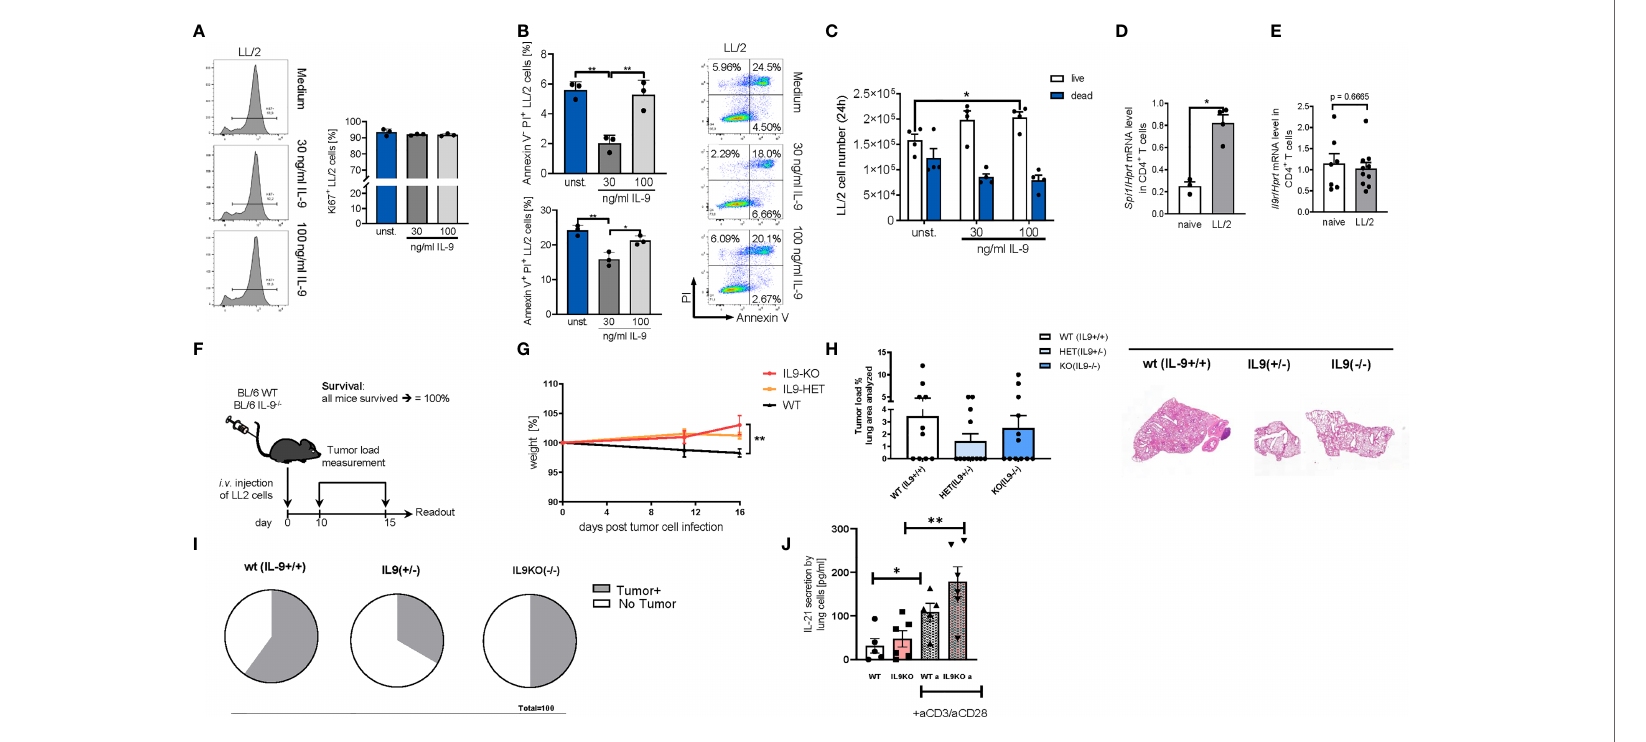
FIGURE 6 | Targeted deletion of IL-9 resulted in lung tumor rejection in BL6 syngenic mice. (A) In vitro studies of murine LL/2-luc-M38 (LL/2) lung carcinoma cells treated with/out recombinant IL-9 for 24h. Flow cytometry analysis of the percentage of Ki67 expressing LL/2 cells after stimulation with or without IL-9 for 24h and representative histograms (left) (n unst. = 3; n30 ng/ml=3; n100 ng/ml=3). (B) Annexin V/PI fl ow cytometry analysis of LL/2 cells after stimulation with or without IL-9 for 24h and representative dot plots (n unst. = 3; n30 ng/ml=3; n100 ng/ml=3). (C) Cell count by using Neubauer chamber. Bar charts indicate mean values ± SEM using student´s two-tailed t -test (b – g) or ordinary one-way ANOVA (i – j) (*p<0.05, **p<0.01, ***p<0.001). (D) qPCR based analysis of Spi1 encoding PU.1 (n naive =3; n LL/2 = 4) and (E) Il9r (n naive =7; n LL/2 = 10) in relation to Hprt mRNA level in CD4 + T cells isolated cells from the lung of naïve and lung tumor-bearing (LL/2) WT mice. (F) Experimental design for the induction of lung tumor development in BL/6 WT, BL/6-IL-9 +/- and BL/6 IL-9 -/- mice which were intravenously (i.v.) with LL/2-luc-M38 (LL/2) lung carcinoma cells on day 0. The experiment ended on day 16. (G) Monitored body weight during tumor development. (H) Quanti fi cation of the tumor-in fi ltrated area of the lung (left) and representative H&E staining of the lung of WT, IL-9 +/- and IL-9 -/- mice (right) (n WT =10; n IL-9+/-= 10 n IL-9-/- =10). (I) Circles represent mice per group tumor free (circle sectors in white) and mice with lung bearing tumor (sectors in grey). (J) ELISA analysis of IL-21 levels (pg/ml) in supernatant obtained from cells isolated from the lung of wild-type and IL-9 -/- tumor-bearing mice. Lung cells were cultured for 4 days unstimulated or re-stimulated with aCD3/aCD28 antibodies (n WT =5, n IL9-/-